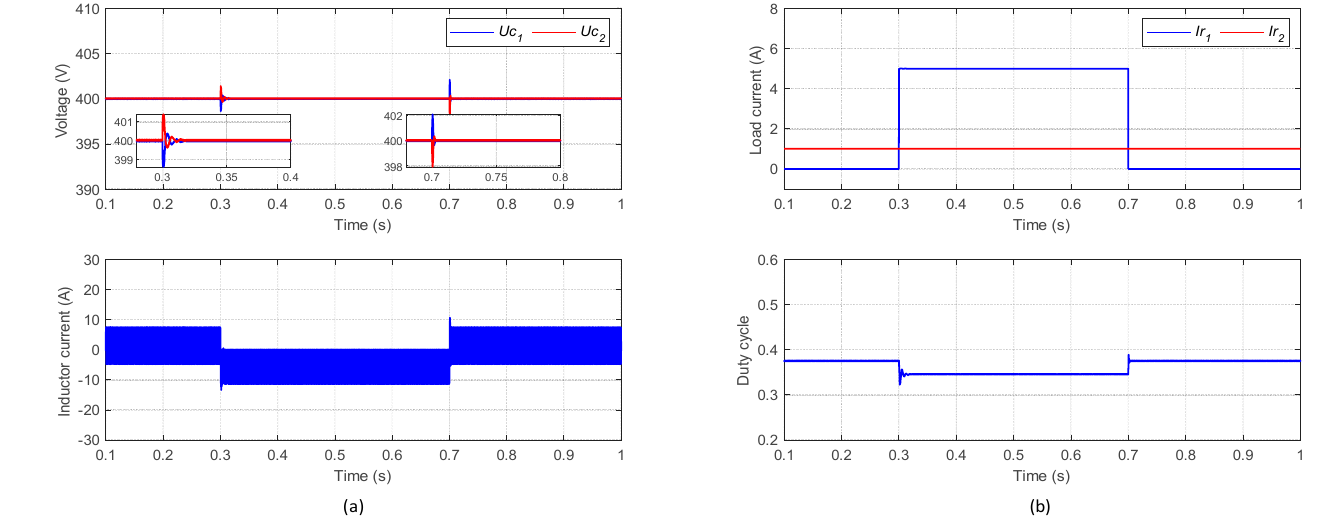
Figure 10. I R 1 Load transient response using the proposed CCS–MPC. ( a ) Inductor current and Figure 10. 𝐼 Load transient response using the proposed CCS – MPC. ( a ) Inductor current and 𝑅1 output voltages. ( b ) Duty cycle and load current. output voltages. ( b ) Duty cycle and load current.